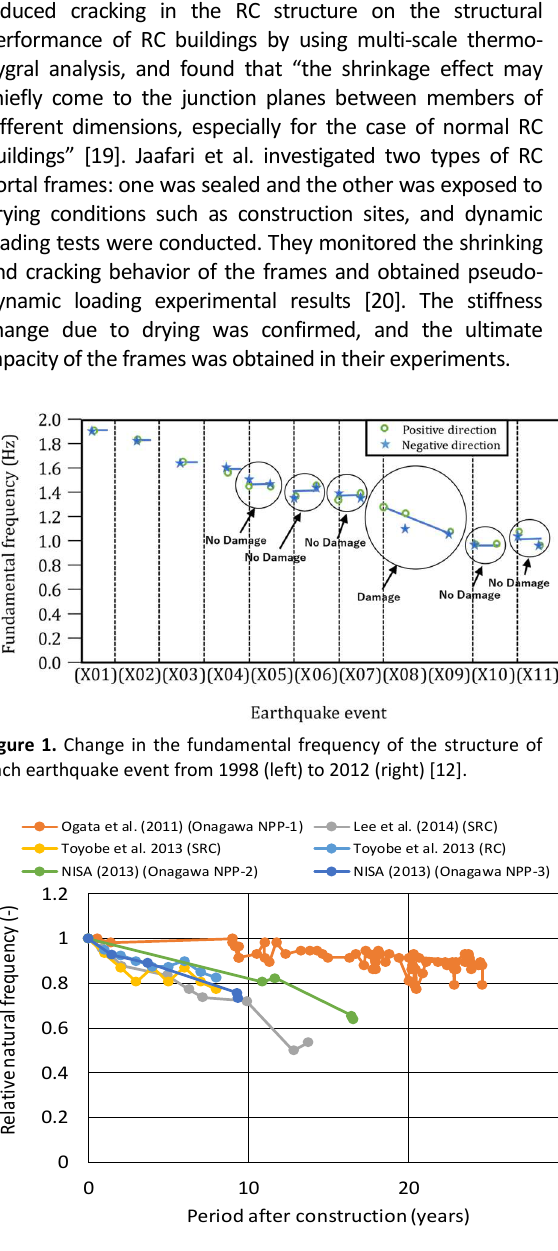
Figure 2. Change in the relative natural frequencies of concrete buildings (after